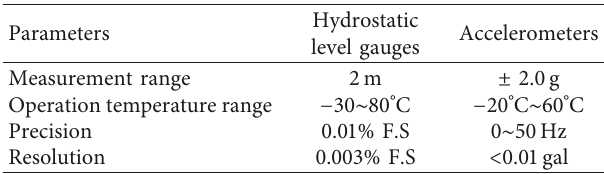
Table 3: Properties of hydrostatic level gauges and